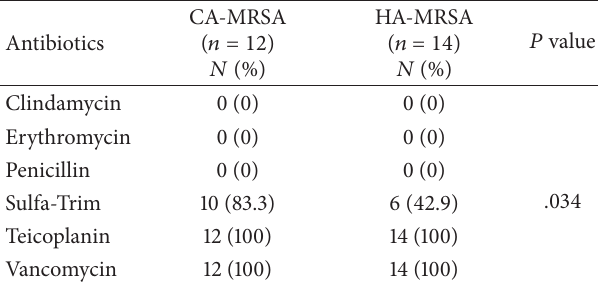
Table 4: Antibiotic susceptibility of community-associated meth- icillin-resistant Staphylococcus aureus (CA-MRSA) and healthcare- associated methicillin-resistant Staphylococcus aureus (HA-MRSA)